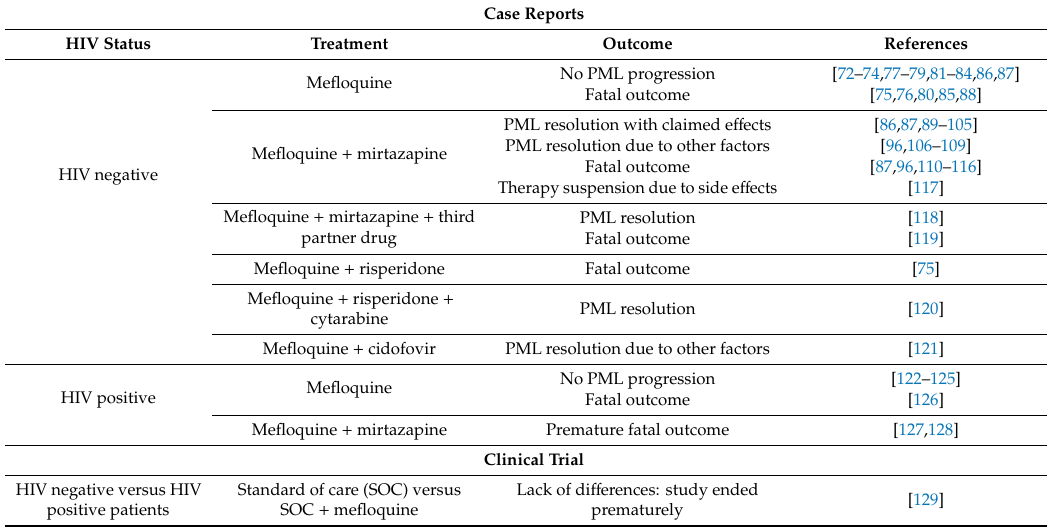
Table 2. Clinical studies assessing the e ffi cacy of Mefloquine (MQ) treatment and its combinations in JCPyV-infected progressive multifocal leukoencephalopathy (PML)